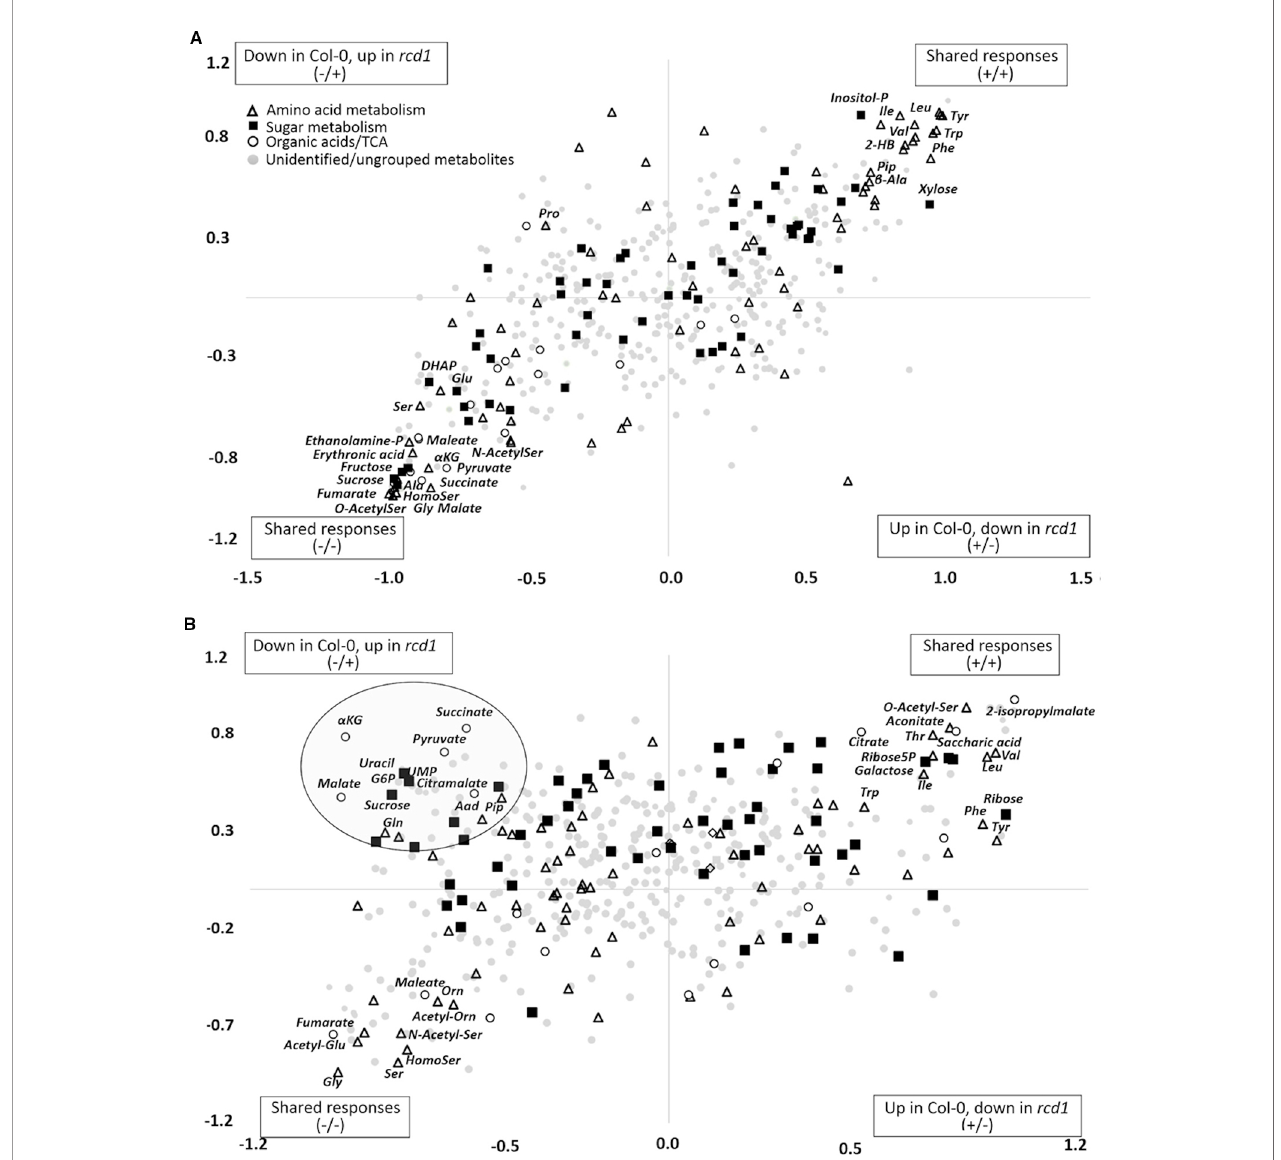
FIGURE 2 | (A) Shared and unique structures (SUS)-plot of discriminant analysis (OPLS-DA) comparing metabolite responses of rcd1 and Col-0 to extended darkness and to (B) MV treatment. Metabolites displaying similar responses in both plant lines are in upper right or lower left corner. Metabolites located along the axes display line-speci fi c responses and metabolites located in the upper left or lower right corner display opposite responses in the plant lines. p(corr) is the OPLS- DA loading scaled as correlation coef fi cient. Dot shapes and colors indicate different metabolite groups. White triangle: amino acid metabolism, black square: sugar metabolism, white circle: organic acids/TCA cycle, light gray circle: unidenti fi ed/ungrouped metabolites (n = 6-8). The list of metabolite correlation coef fi cient values are in Supplementary Table S6